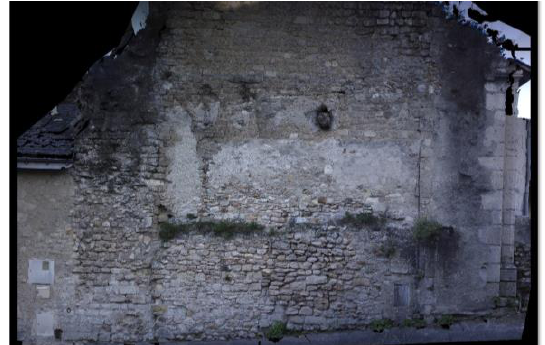
Figure 8. Orthoimage of the west wall of the north transept church